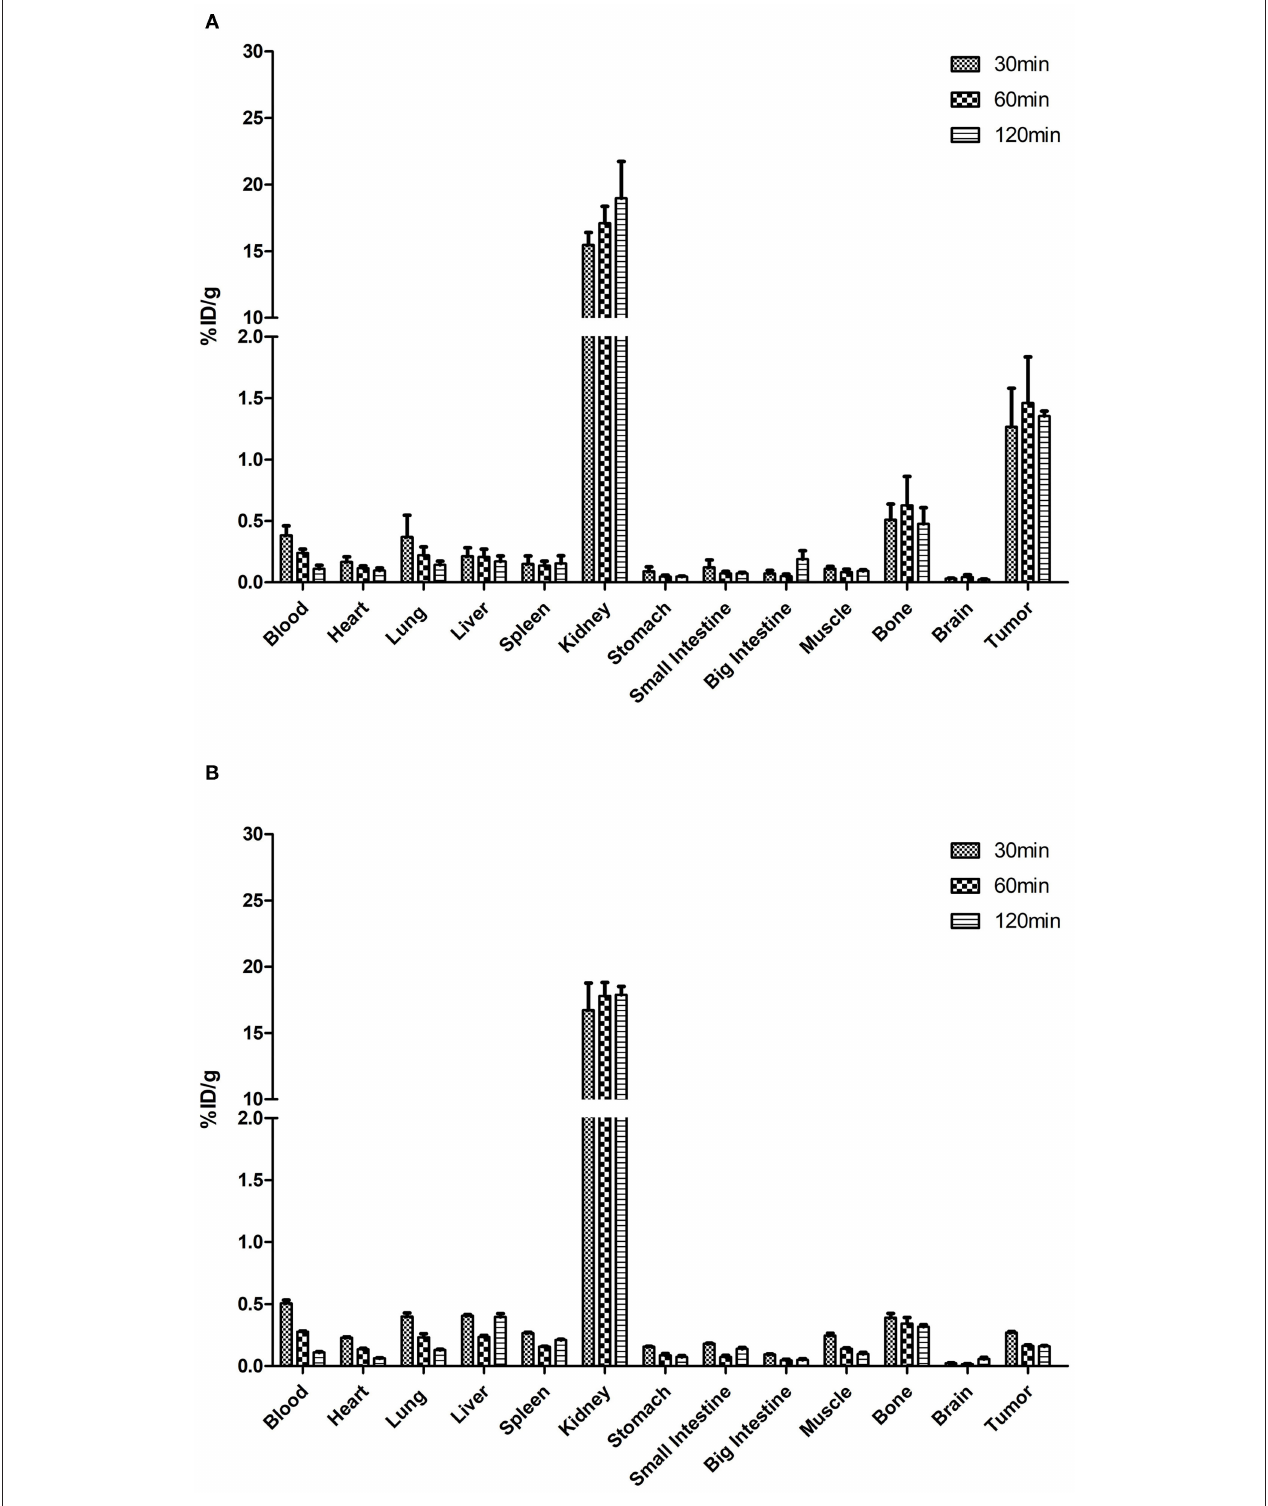
FIGURE 4 | Biodistribution of the [ 18 F]AlF-NOTA-HER2 affibody in mice-bearing NCI-N87 (A) and MKN74 (B) tumors.